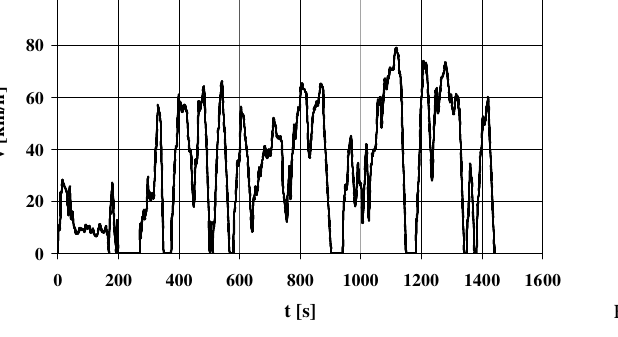
Fig. 3. Speed curve – v in the Malta test cycle